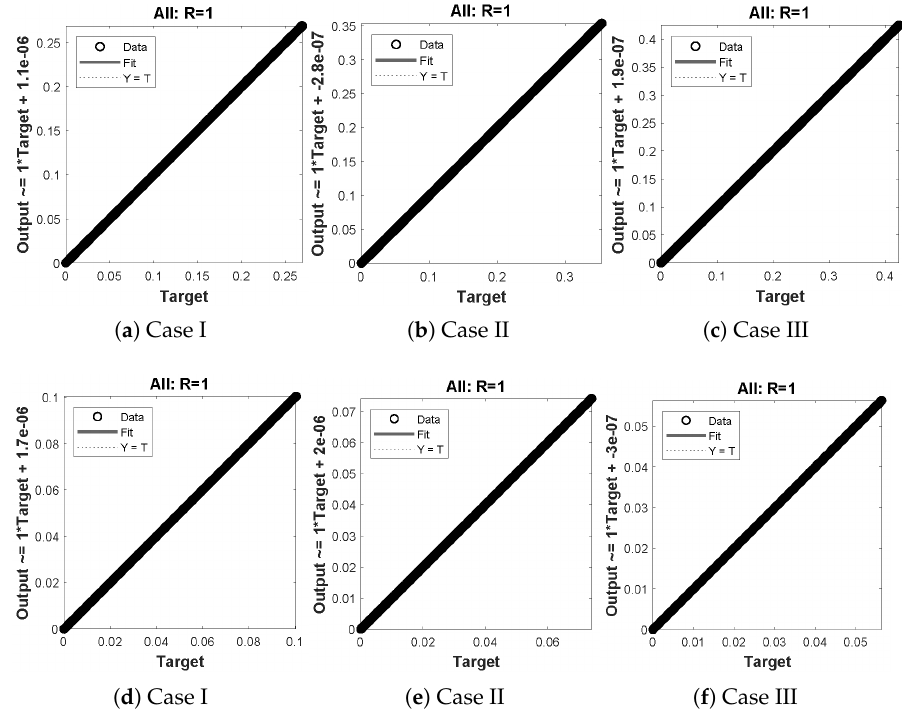
Figure 14. ( a – f ) shows the regression analysis for dimensionless concentration of hydrogen peroxide of micro-disk biosensor